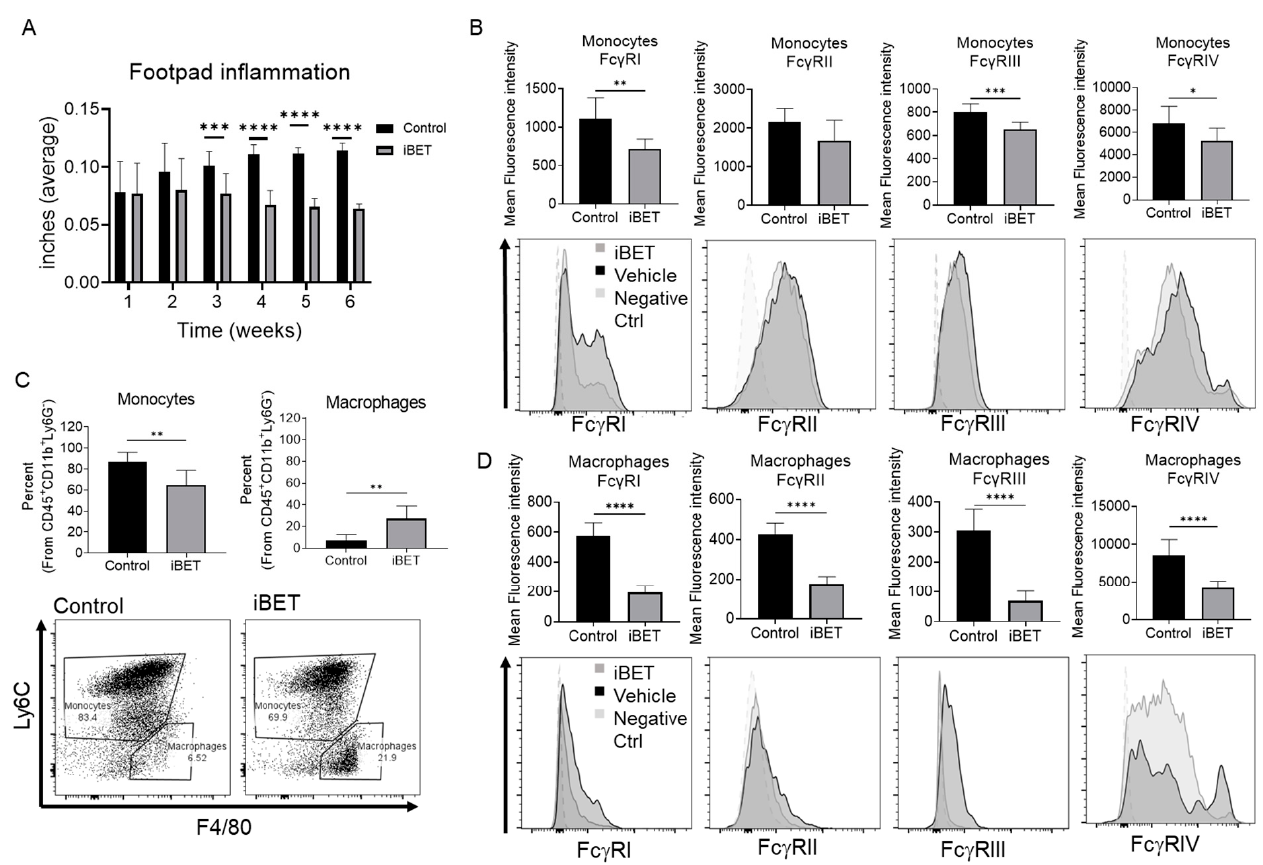
Figure 7. BET inhibition reduces footpad inflammation and Fc γ R expression in vivo. DBA mice were injected with collagen type II as indicated in the methods to induce rheumatoid arthritis. After 2 weeks from the last collagen injection, mice were treated with vehicle or PLX51107 (iBET) at 10mg/kg three times a week for 5 weeks. During the treatment, ( A ) footpad swelling was measured every week, showing the average between left and right front foot (n = 10 per group). Mice were then sacrificed 2 weeks after the last treatment, spleens obtained and used to detect expression of Fc γ Rs in ( B ) monocytes, and ( D ) macrophages, as well as the percentage of ( C ) monocytes and macrophages. Graphs show the mean fluorescence intensities, as well as representative histograms below. * p ≤ 0.05, ** p ≤ 0.01, *** p ≤ 0.001, **** p ≤ 0.0001